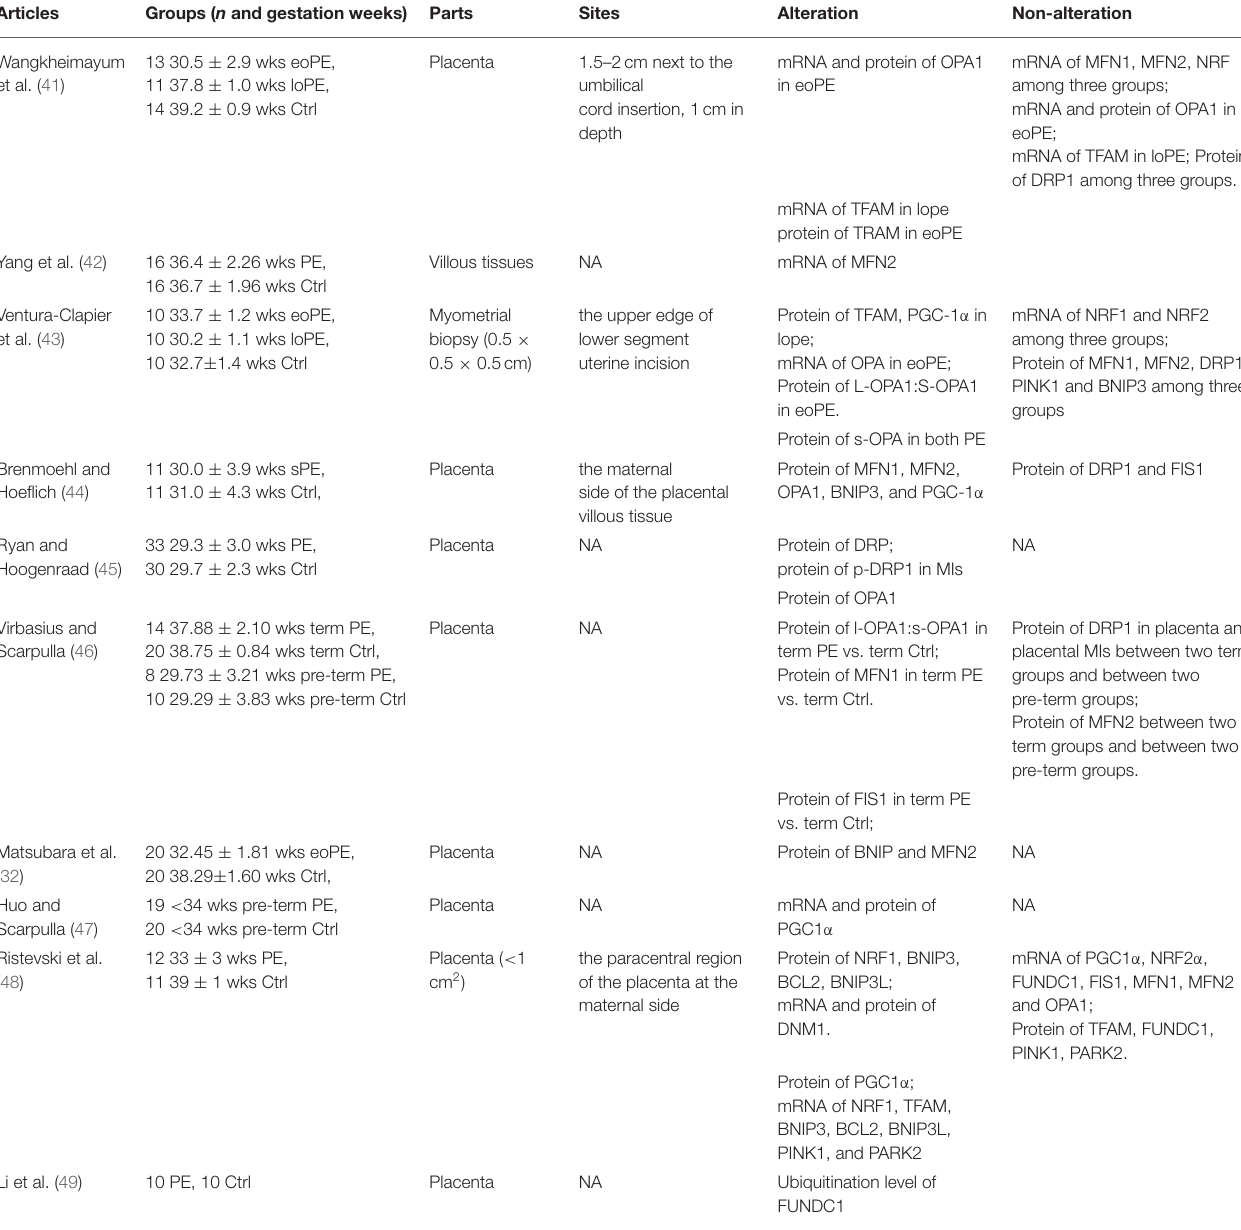
TABLE 1 | Summary of current studies in humans related to mitochondrial quality control molecules. Articles